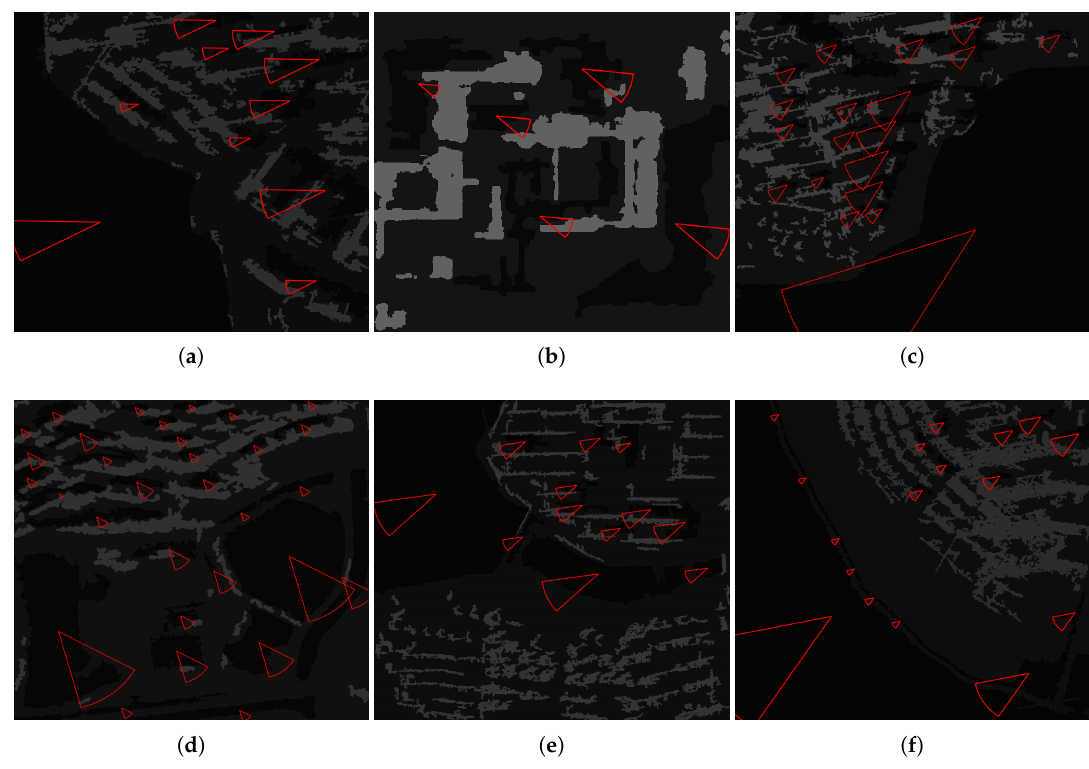
Figure 5. The fan-shape searching strategy from the shadow mass center to the corresponding building (the radius of the fan-shape searching sector is r , and the angle of the fan-shape is θ ).